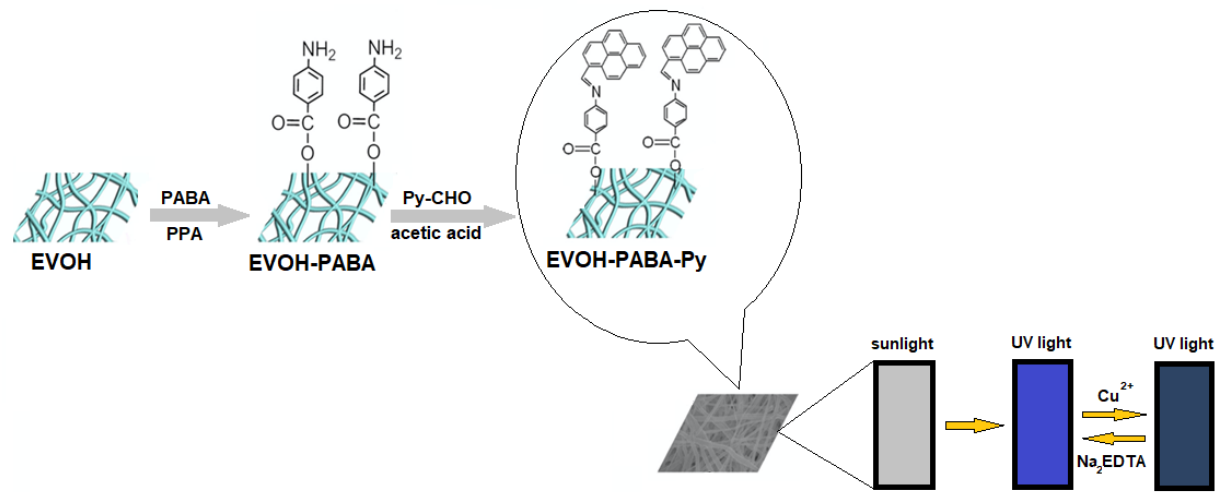
Figure 13. General scheme of the synthesis and the application of the sensor for Cu 2+ .